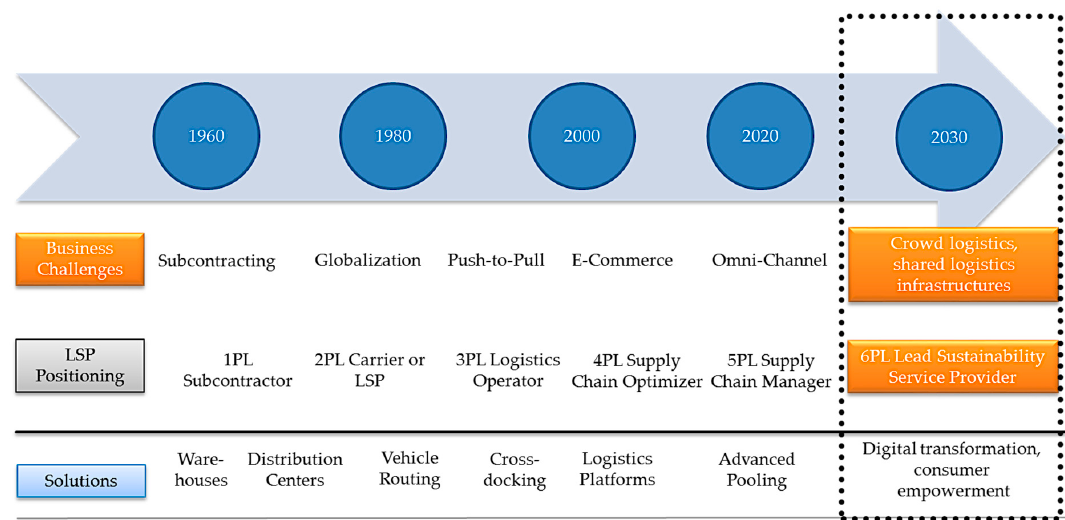
Figure 9. LSP’s sustainability roadmap.